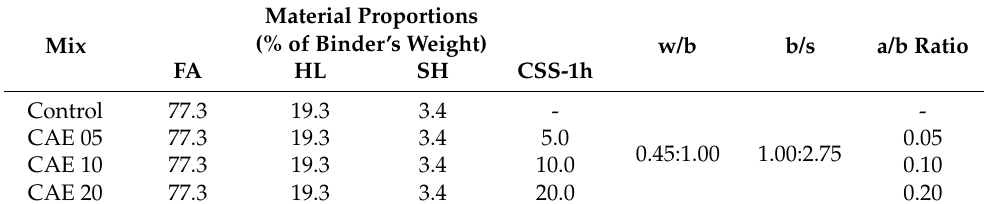
Table 3. Mortar mix design used in this study.